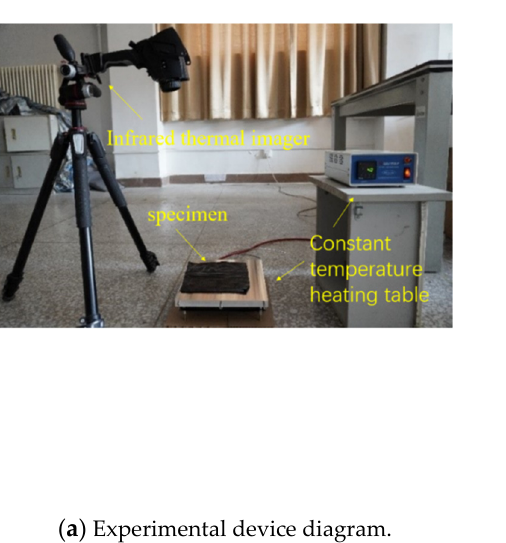
Figure 1. Experimental device and damage specimens diagram.